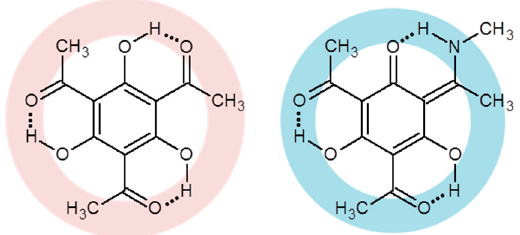
Figure 7. The derivatives of the phloroglucin (1,1 ′ ,1 ″ -(2,4,6-trihydroxybenzene-1,3,5-triyl)trietanon, left structure) and tris -hydroxy ketoimine structures ((1E)-1-(3,5-diacetyl-2,4-dihydroxy-6-oxocyclohexane-2,4-dieno-1-yl)-N-methylethaniminium, right structure).